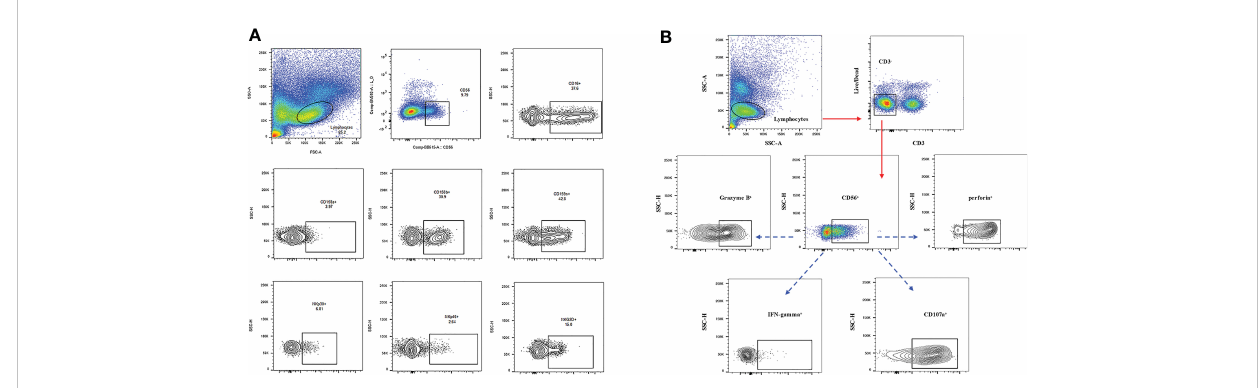
FIGURE 1 (A) The gating strategy used to identify NK cell subsets by fl ow cytometry and the frequencies of gated populations are shown for a representative HC. Lymphocytes were gated according to forward and side scatter dot plots. Single cells were gated according to forward height and side scatter forward area. Dead cells were excluded by staining with Live/Dead fi xable viability stain 510. NK cells were de fi ned within the CD3-gate on the basis of the expression of CD16 and CD56. (B) Cell surface cd3-apc-h7, cd56-bb515, and cd16-pe staining were performed fi rst. After washing at 4°C for 20 mins, 2mL PBS was added and 600g cells were immersed for 3 mins to discard the supernatant. Then the cells were exploded and be product solution was added for 20 mins at 4 °C. After washing, IFN- g -BV711, Perforin-AP647, Granzyme B-BV421, and CD107A-PE-CY7 were added and they were incubated at 4°C for 20 mins without light. After washing once with the broken membrane detergent, the machine was used for detection.